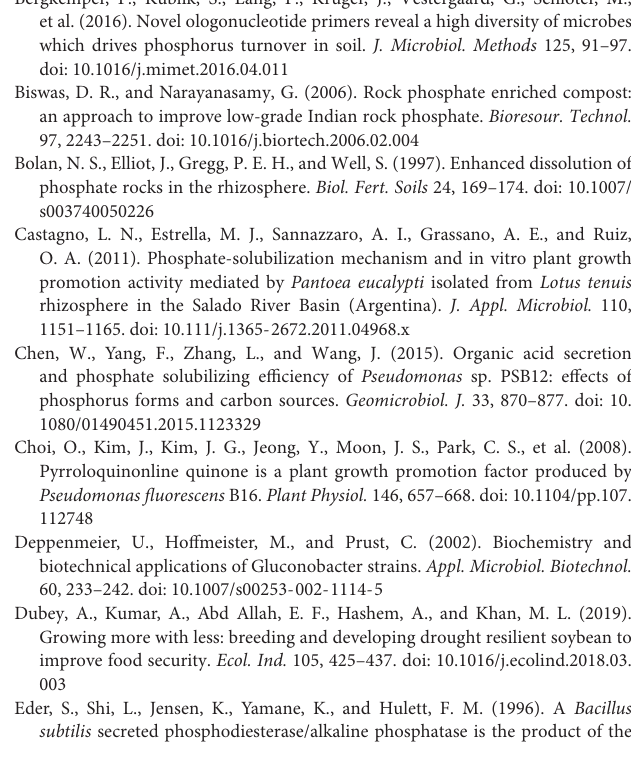
FIGURE S1 | Relationships between PC1 scores and labile P, total P, residual P, and gene’s